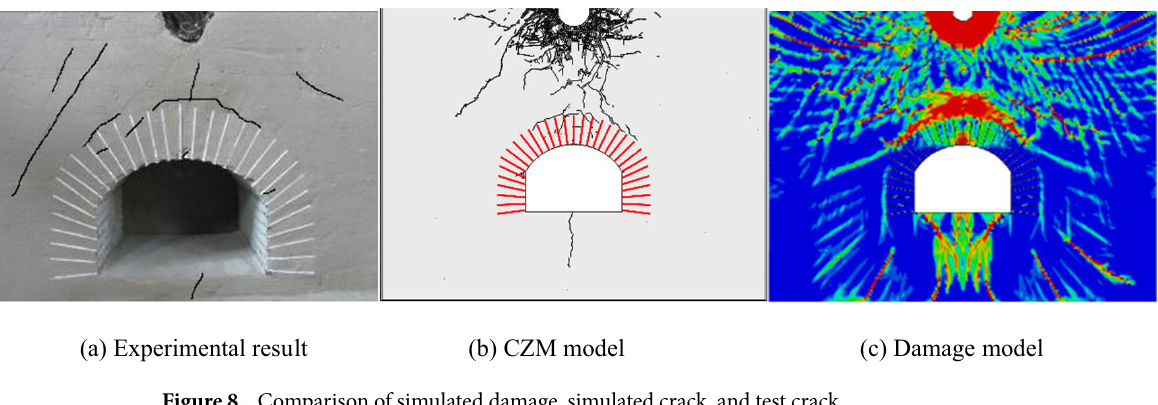
Figure 8. Comparison of simulated damage, simulated crack, and test